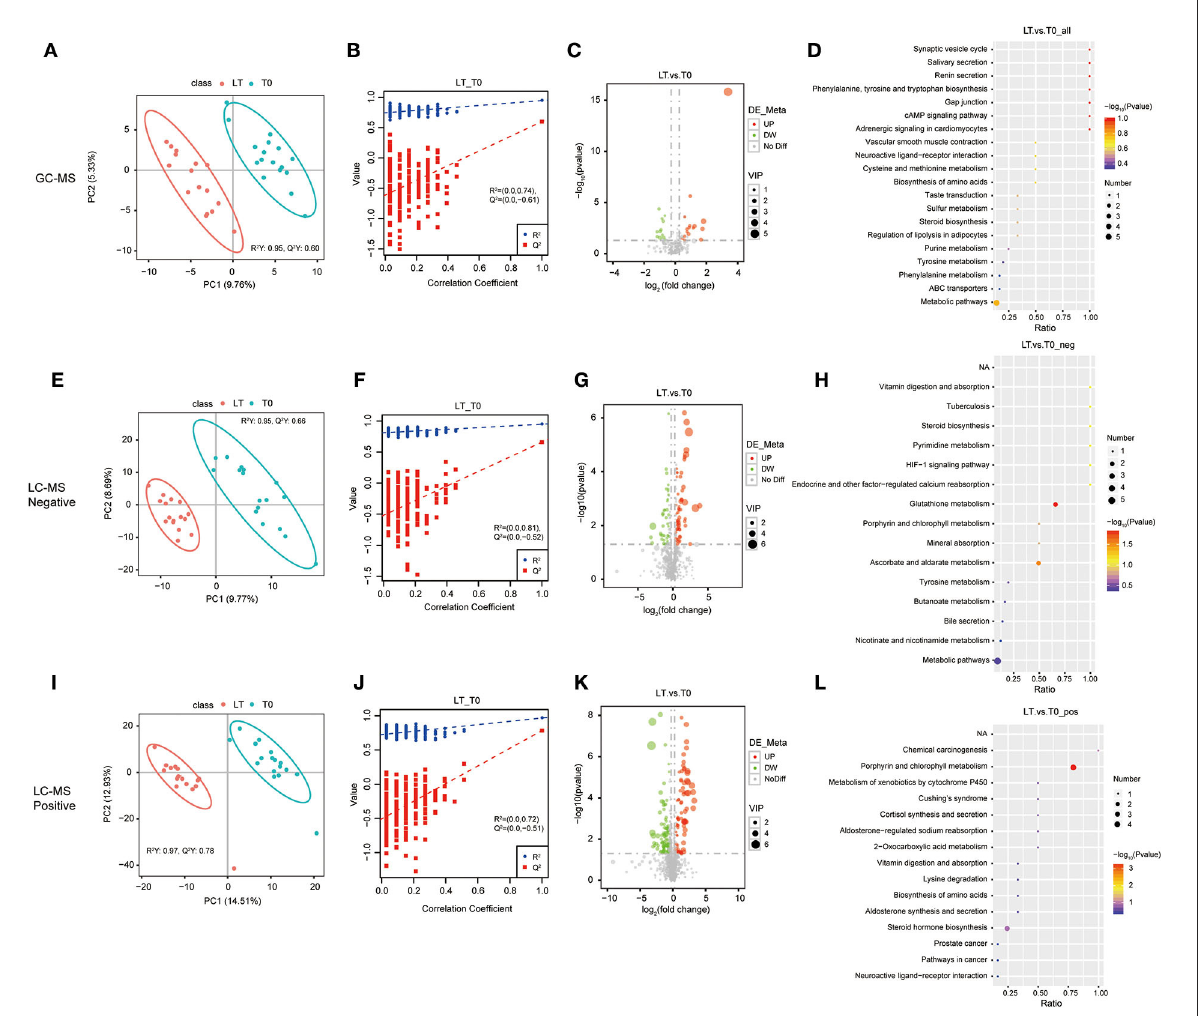
FIGURE1 Identification of serum metabolites between latent tuberculosis infection (LT) and the untreated PTB group (Un). The PLS-DA model for the LT/Un group in GC-MS (A) , LC-MS/MS (–) (E) , and LC-MS/MS ( + ) (I) . The permutation test results for the LT/Un group in GC-MS (B) , LC-MS/MS (–) (F) , and LC-MS/MS ( + ) (J) . Volcanic map of differential metabolites for the LT/Un group in GC-MS (C) , LC-MS/MS (–) (G) , and LC-MS/MS ( + ) (K) . The abscissa: the fold change of LT/Un group (base 2 logarithm). The ordinate: the P -value of LT/Un group (base 10 logarithm). Red: significantly upregulated metabolites. Green: significantly downregulated metabolites. Gray: non-significant differential metabolites. Pathway analysis of differential metabolites for the LT/Un group in GC-MS (D) , LC-MS/MS ( - ) (H) , and LC-MS/MS ( + ) (L) .